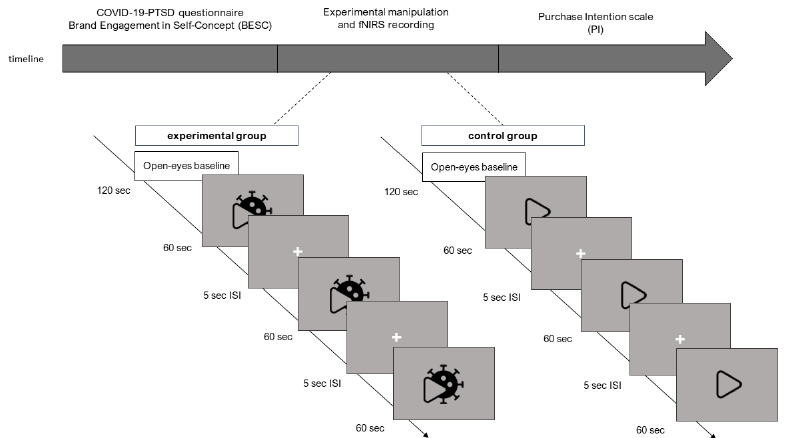
Figure 1. Experimental procedure. The timeline of the study is shown in Figure 1. After the COVID- 19-PTSD questionnaire and the Brand Engagement in Self-Concept (BESC) scale were administered, a 120 s open-eyes baseline was recorded with the fNIRS (functional Near-Infrared Spectroscopy). The neural correlates were recorded during the experimental manipulation, which differed between the two groups: the experimental group (on the left) observed the three COVID-19-related video ads, while the control group observed the three COVID-19-unrelated video ads (on the right), in randomized order. Each stimulus lasted 60 s. and an inter-stimulus interval of 5 s was displayed before the next stimulus. Finally, the Purchase Intention (PI) scale was filled out.